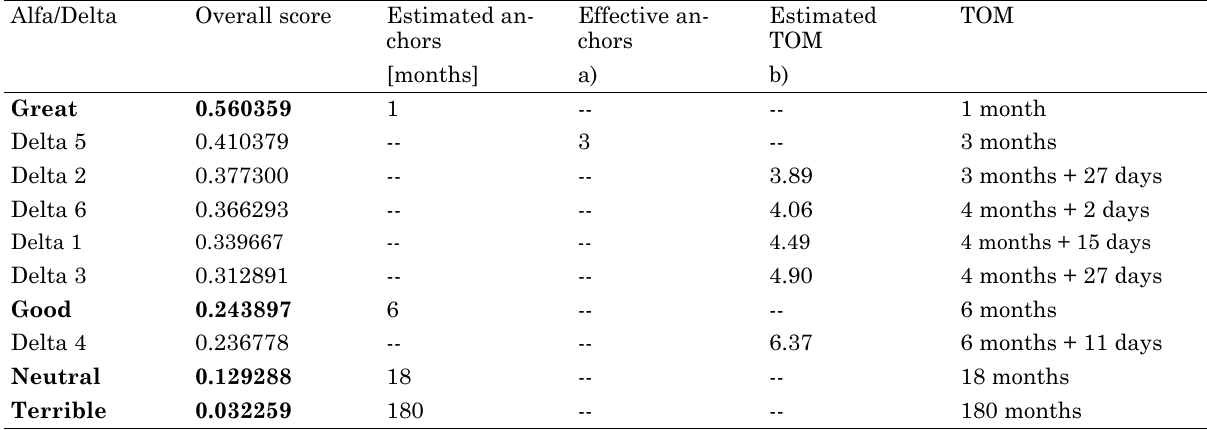
Table 8. TOM predictions for Alphas and Deltas